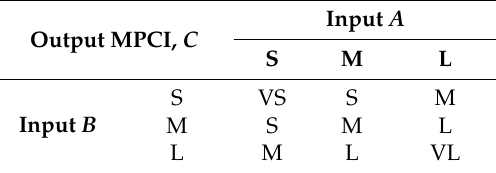
Table 4. Fuzzy inference table in cloud